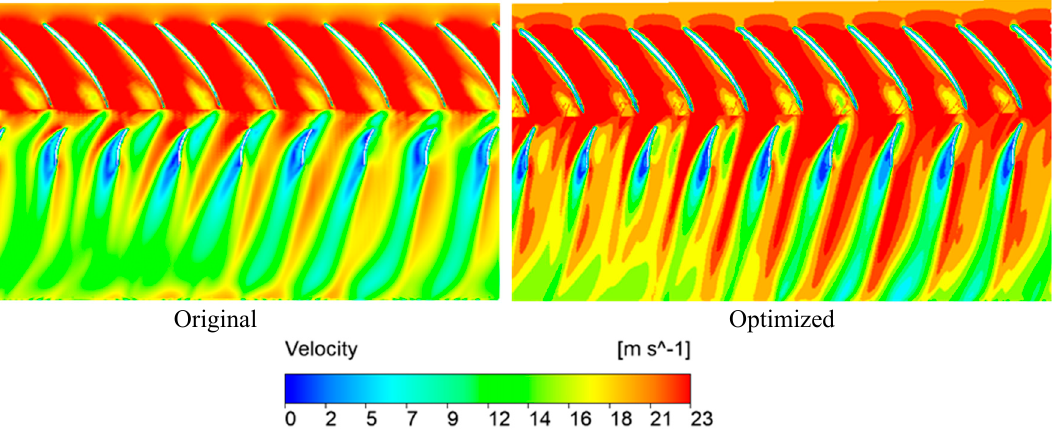
Figure 20. The velocity distribution at 0.5 blade height before and after optimization.